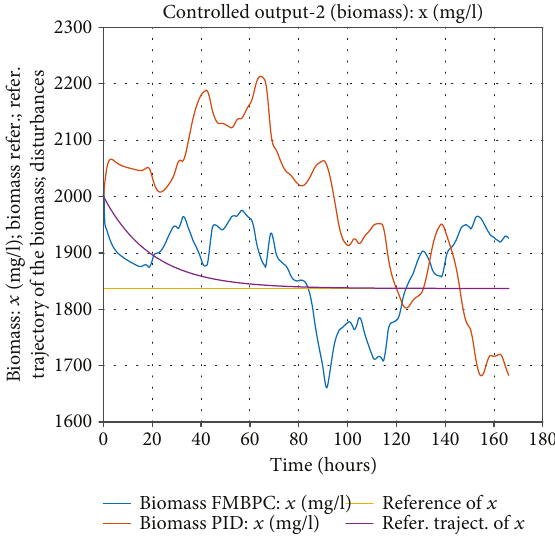
Figure 27: Reactor biomass by FMBPC and PID (case D). Figure 28: Control variables calculated by FMBPC and PID strategies (case